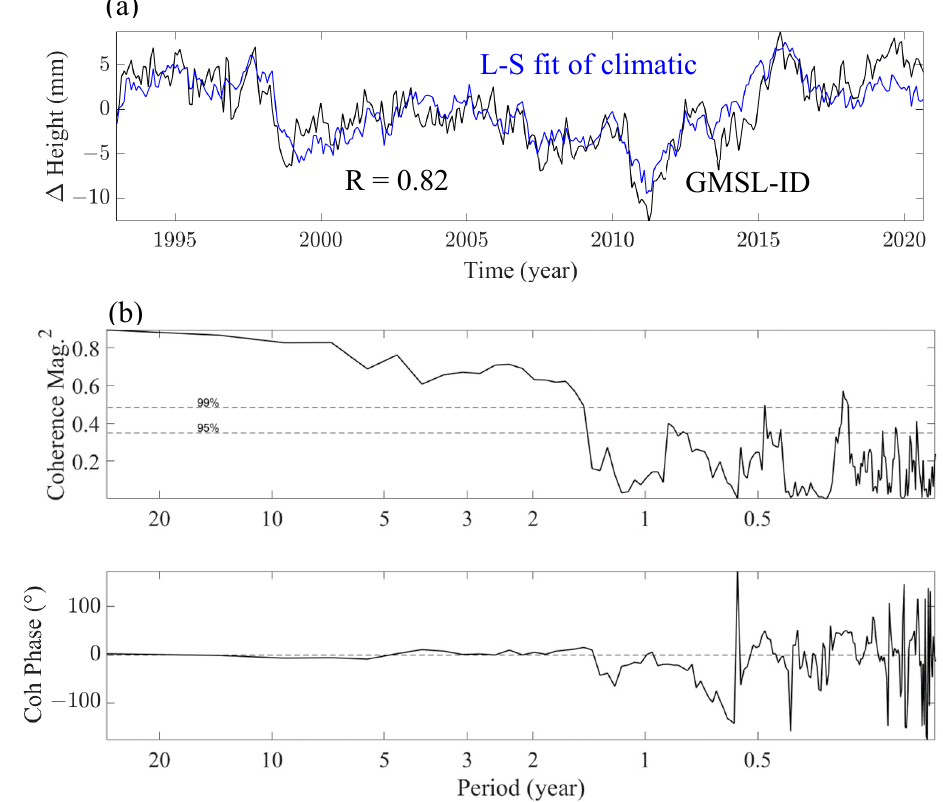
Figure 5. ( a ) Comparison of GMSL-ID ( t ) (black curve) with the least-squares linear combination of the five oscillation indices (blue curve). ( b ) Cross-coherence spectrum between the two time series in ( a ) in terms of magnitude-squared and phase (similar to Figure 4).